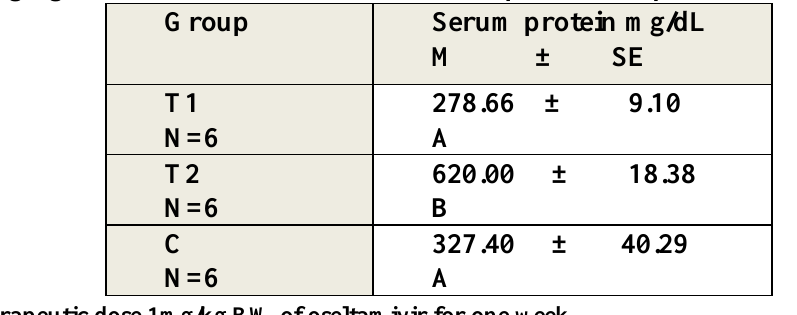
Table (6):- The total serum protein (mg/dL) of rats dosed orally therapeutic dose 1mg/kg.BW of oseltamivir for different experimental periods.